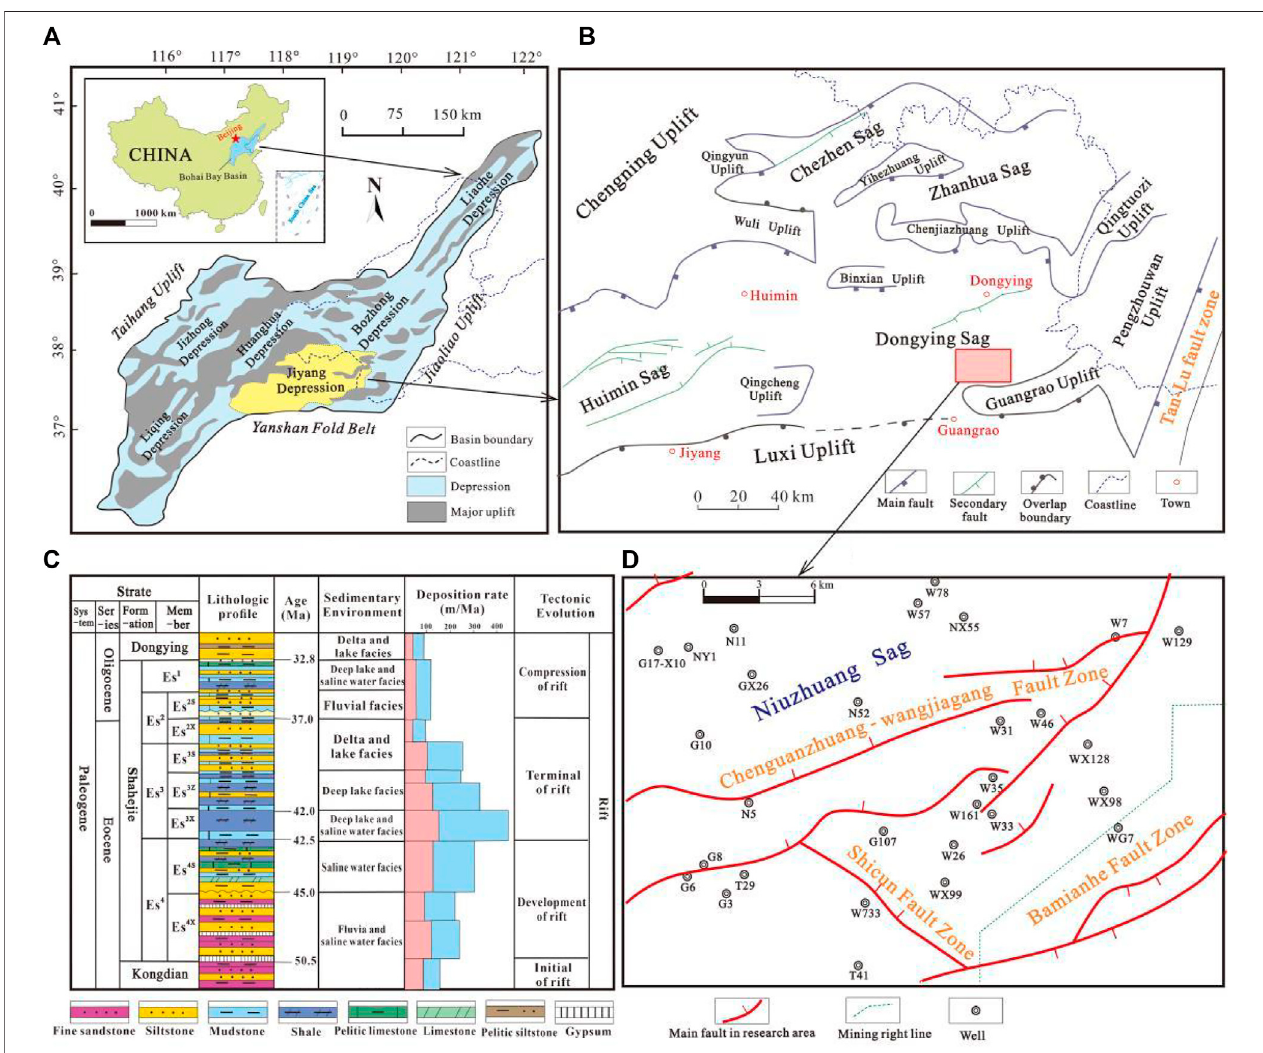
FIGURE1| Comprehensivebar diagram ofregionalgeology and sedimentary evolution. (A) Tectonic overview oftheBohai BayBasin; (B) tectonic overview ofthe Jiyang Depression and the location of the study area; (C) comprehensive bar chart of the Shahejie Formation stratigraphy in the study area; (D) tectonic overview of the study